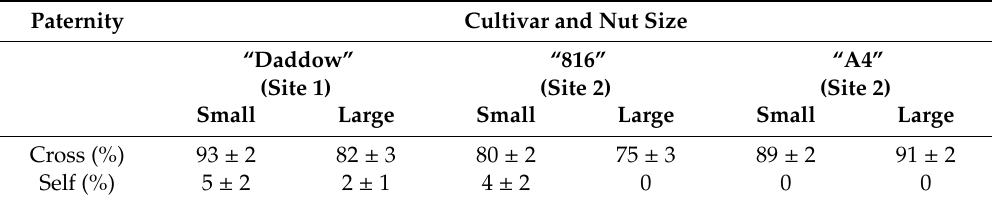
Table 5. Relationships between nut size and identified levels of cross- and self-paternity in macadamia cultivars, “Daddow”, “816” and “A4”, each sampled at one of two commercial orchard sites. Paternity Cultivar and Nut Size “Daddow” “816” “A4” (Site 1) (Site 2) (Site 2) Small Large Small Large Small Large Cross (%) 93 ± 2 82 ± 3 80 ± 2 75 ± 3 89 ± 2 91 ± 2 Self (%) 5 ± 2 2 ± 1 4 ± 2 0 0